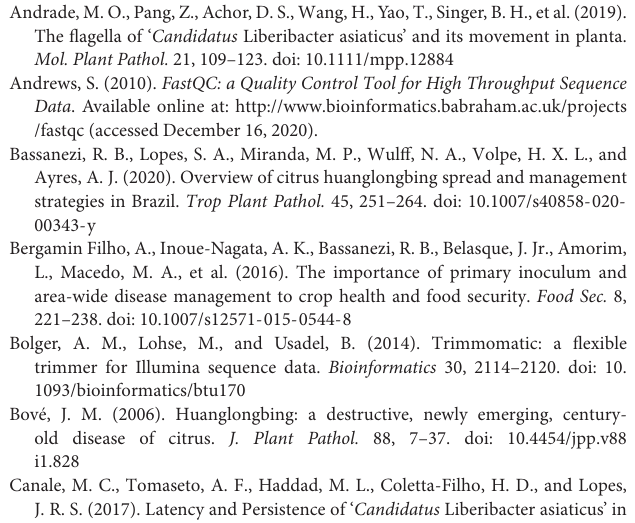
Supplementary Table 1 | The list of exclusive coding sequences mapped only in Las III. Supplementary Table 2 | The list of genes without mapped reads. Supplementary Table 3 | The list of coding sequences for each Las library mapped against Las JXGC genome with FPKM values, average and log2FPKM used for analysis. Supplementary Table 4 | Accession number for each